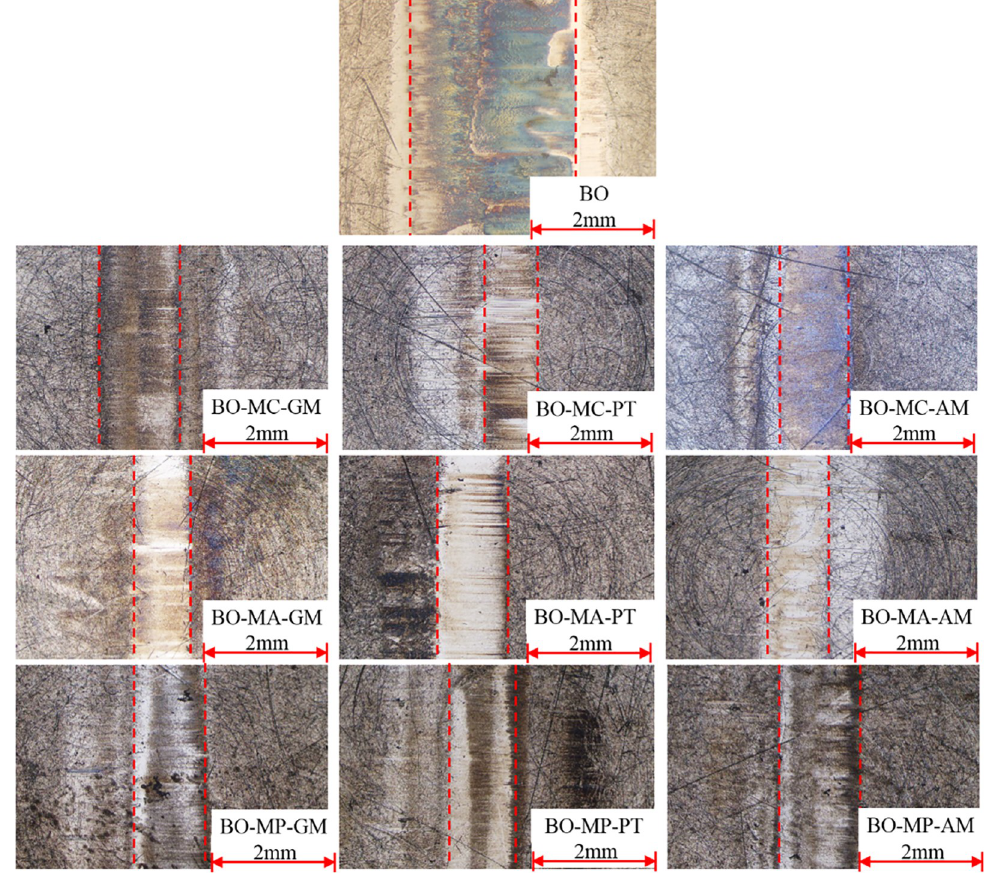
Fig 8. Optical images of block wear